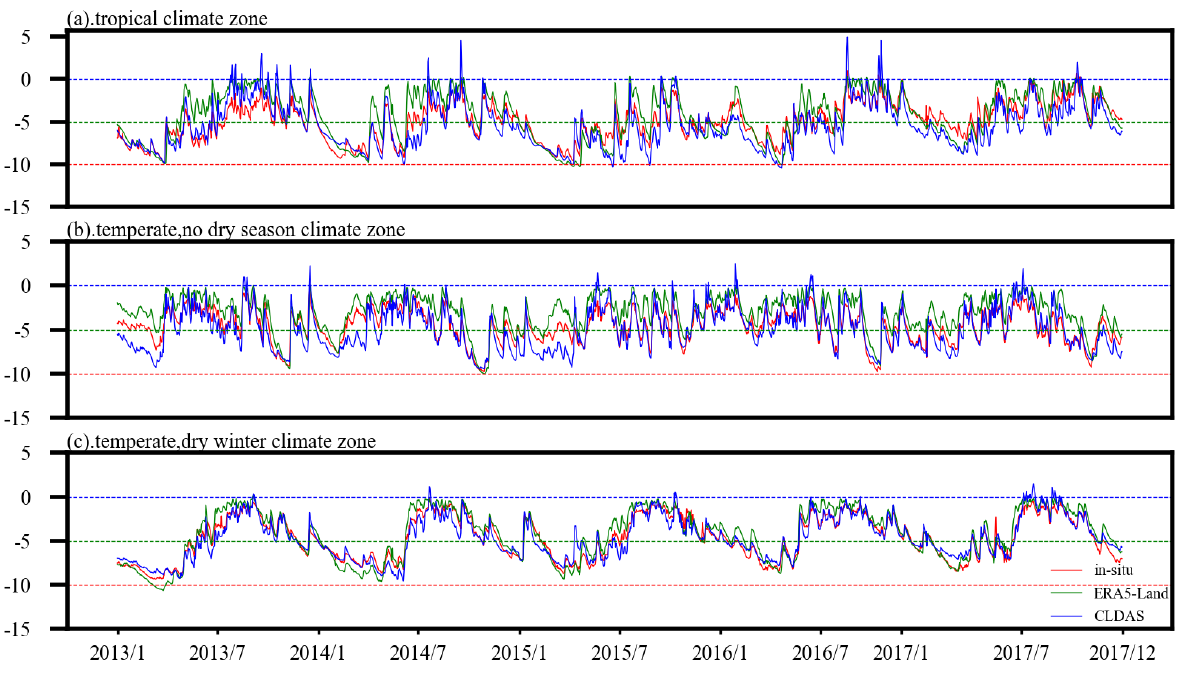
Figure 3. Time series of SWDI from in situ (solid red line), ERA5-Land (solid green line), and CLDAS (solid blue line) data in three climate zones: ( a ) tropical climate zone, ( b ) temperate, no dry season climate zone, and ( c ) temperate, dry winter climate zone.